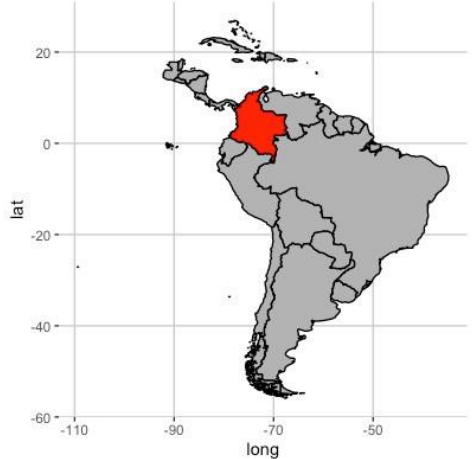
Figure 2. Map of South America, parts of Central America, and the Caribbean, with Colombia highlighted in red, for